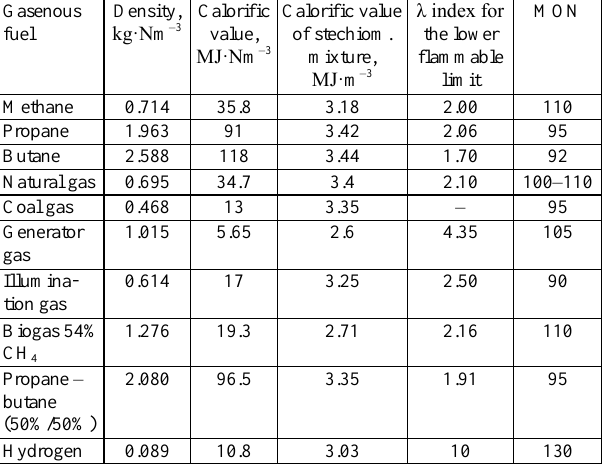
Table 1. Properties characteristic for choosen gasenous fuels [8, 13]